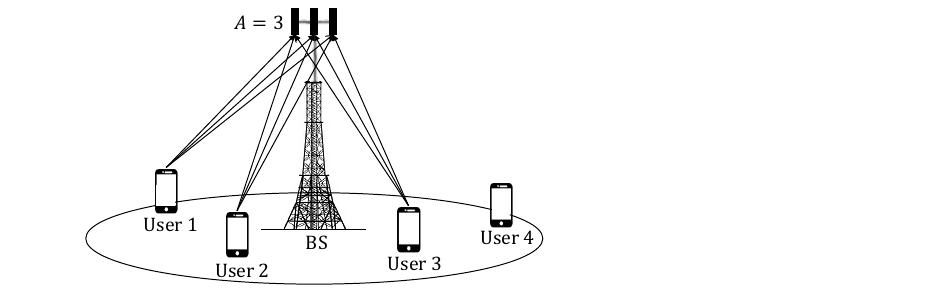
Figure 1. MU-MIMO system with A = 3 antennas in the BS, in which U = 3 users are served simultaneously out of a total of U t = 4 users.